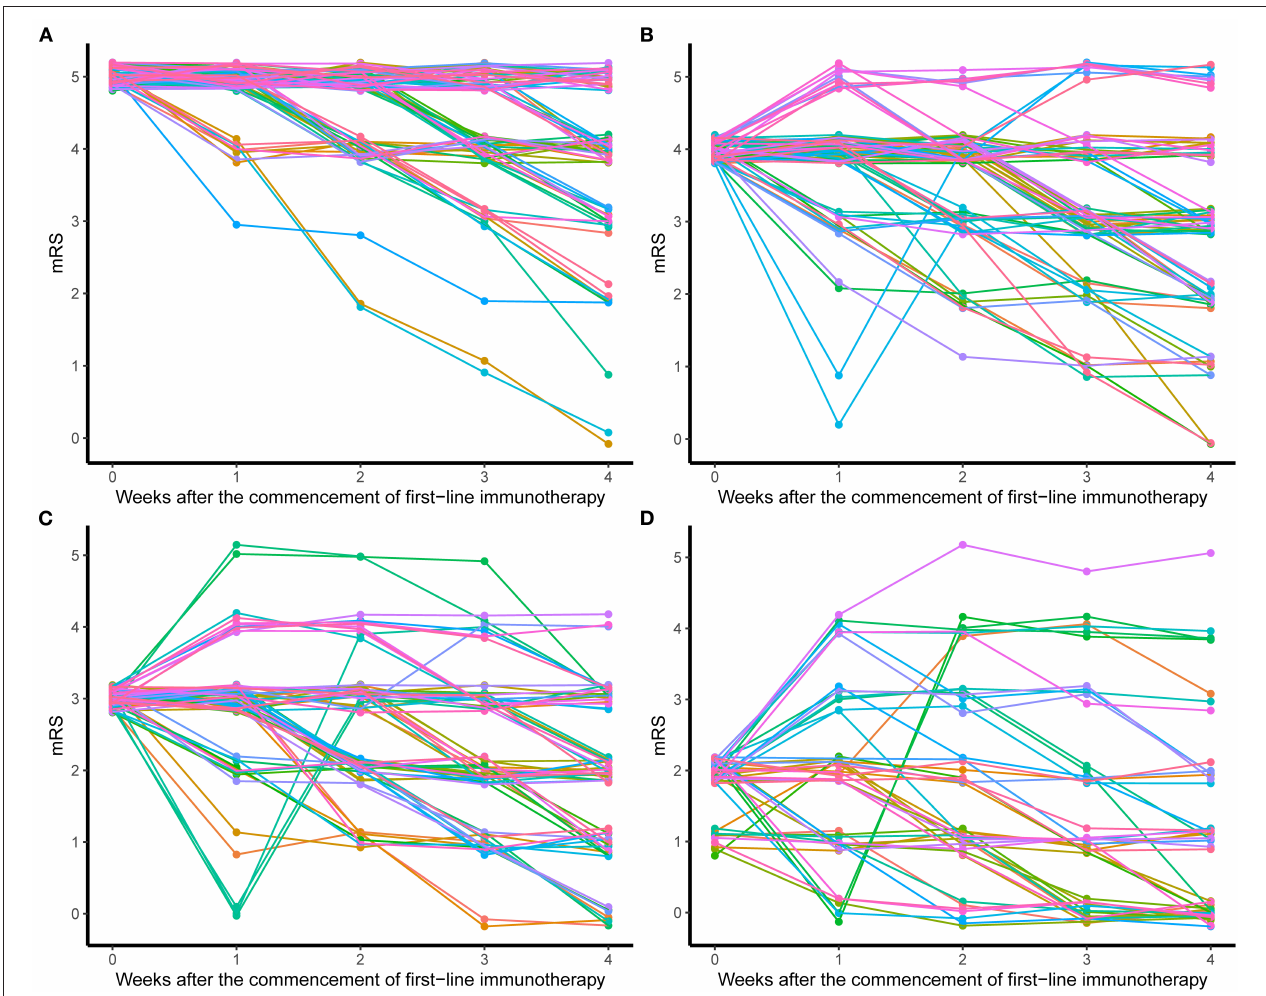
FIGURE 2 | mRS trajectories of patients after the commencement of first-line immunotherapy. (A) Patients with initial mRS = 5. (B) Patients with initial mRS = 4. (C) Patients with initial mRS = 3. (D) Patients with initial mRS ≤